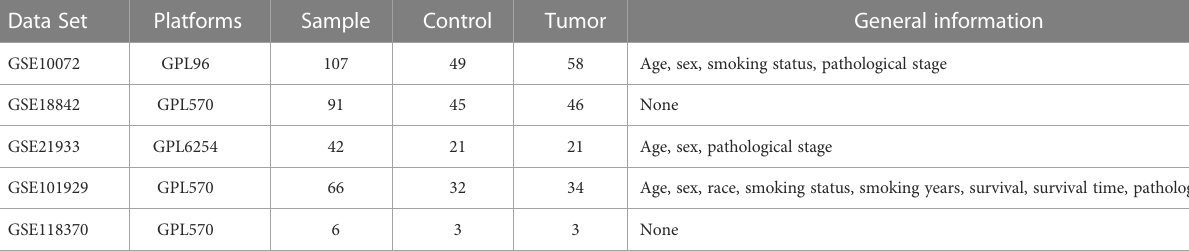
TABLE 1 Characteristics of the GSE